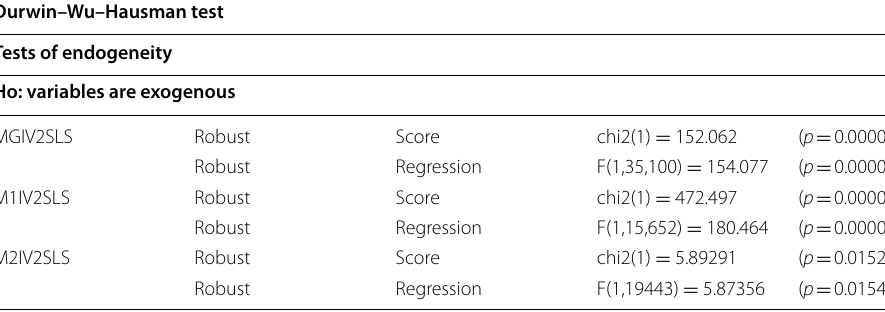
Table 4 Instrumental variables tests